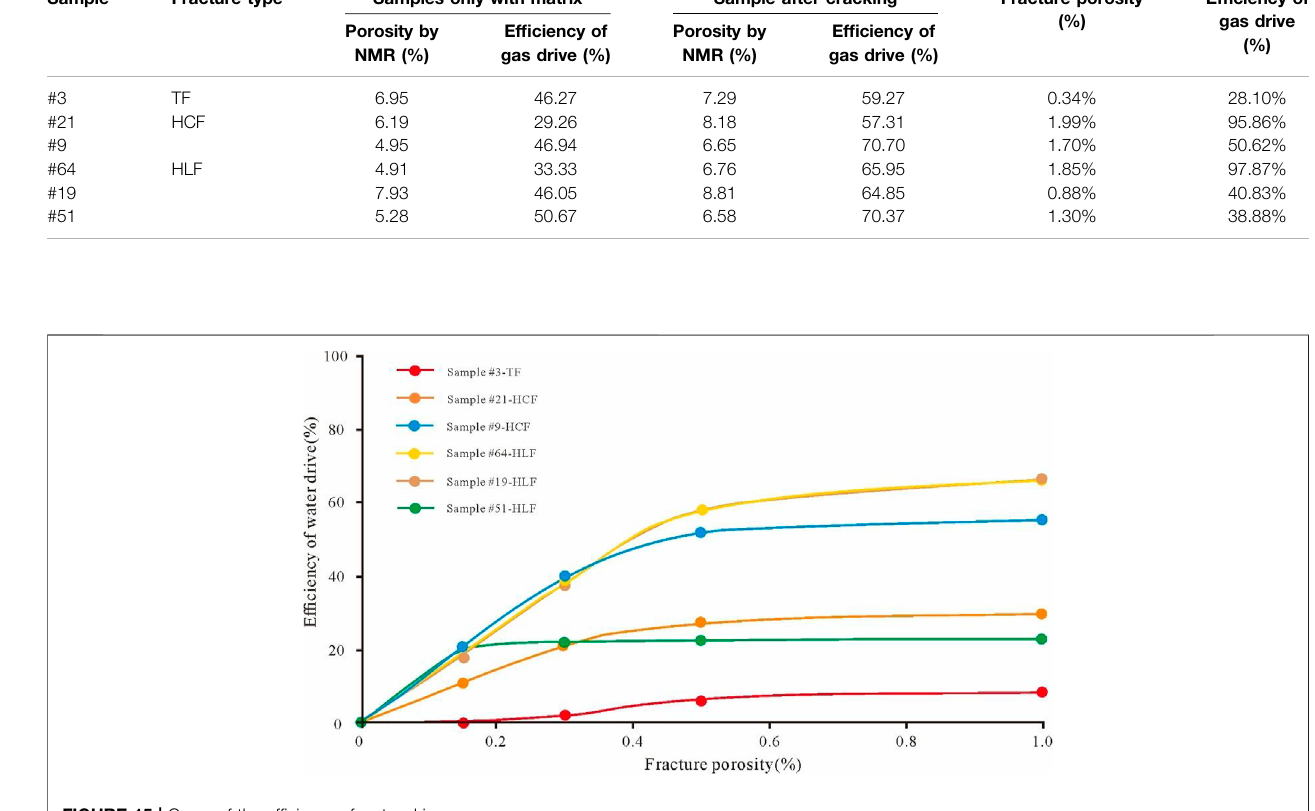
FIGURE 15 | Curve of the ef fi ciency of water drive.